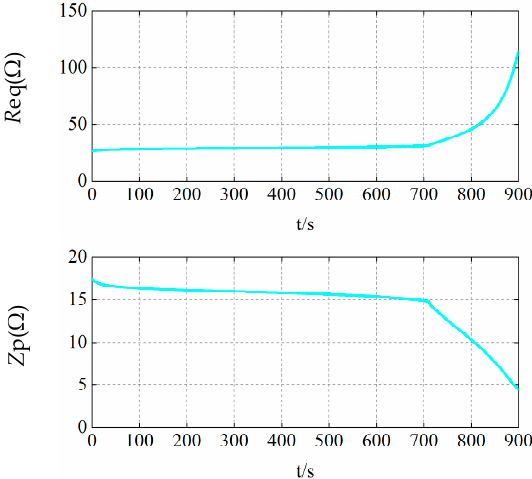
Figure 10. The curve of equivalent load and primary side impedance.